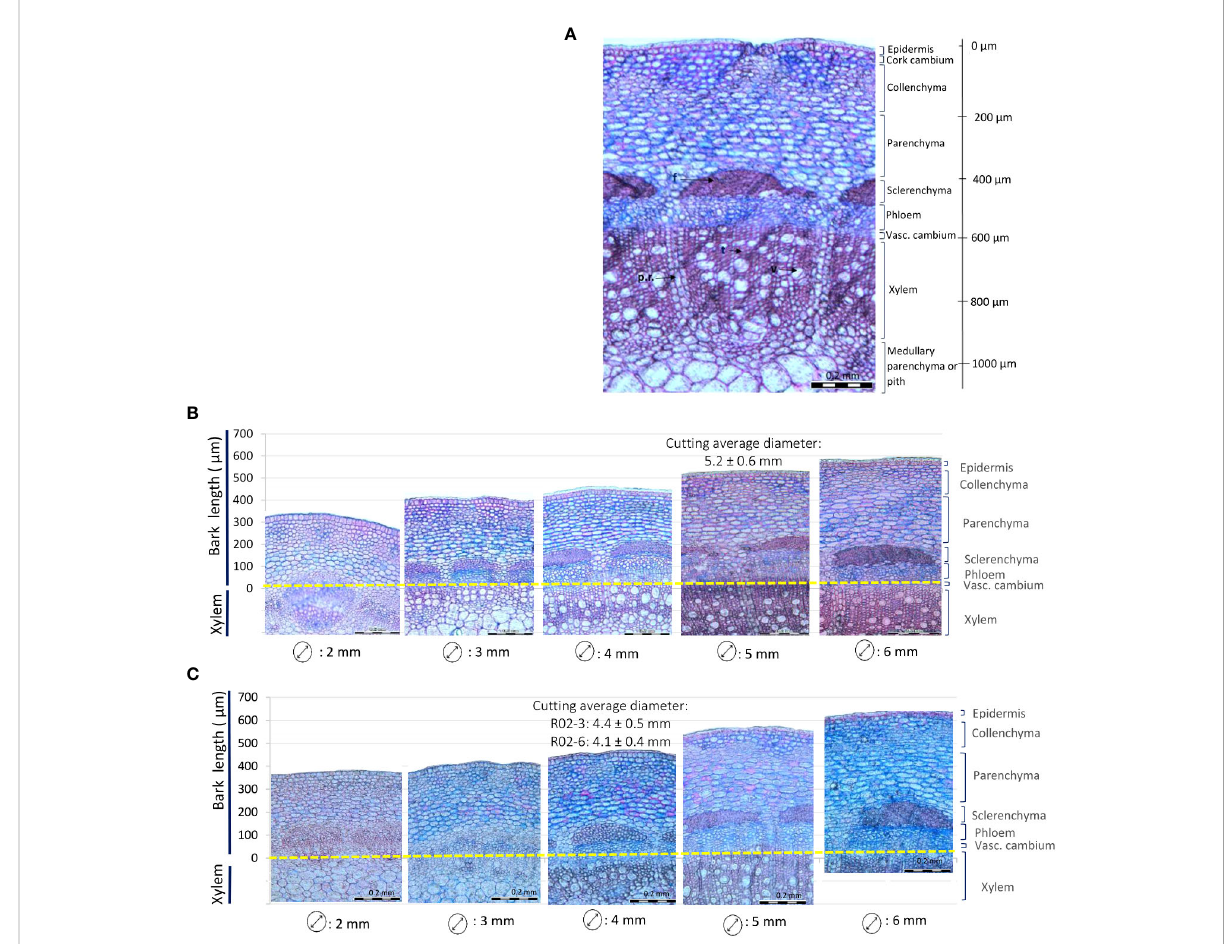
FIGURE 2 Rose stem anatomy depending on the diameter. (A) Partial cross section of a 5 mm rose stem of Rosa ‘ Tan09283 ’ . f: fi bers, p.r.: parenchyma radial, t: tracheid, v: vessel. (B, C) Different stem diameters representing different positions on the shoot for Rosa ‘ Tan09283 ’ (B) and R. canina ‘ Pfänder ’ (C)